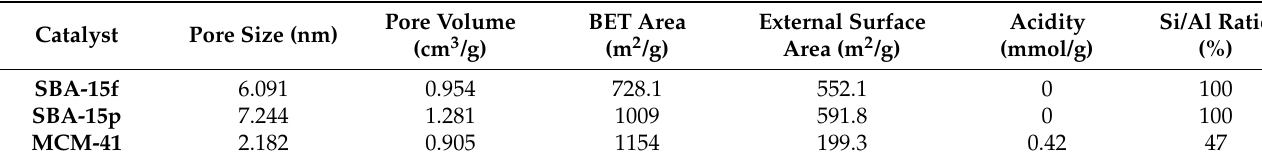
Table 1. Characteristics of catalysts obtained.